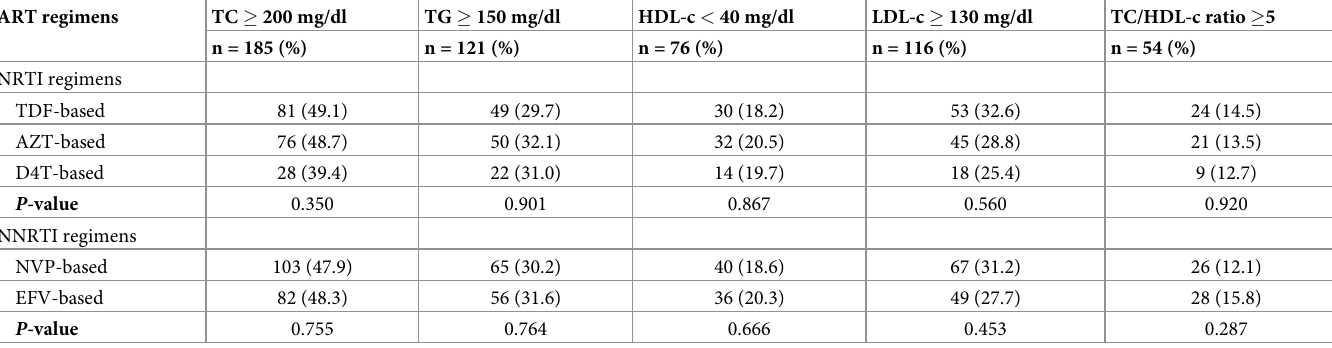
Table 3. Prevalence of lipid abnormalities among patients receiving ART by types of ART